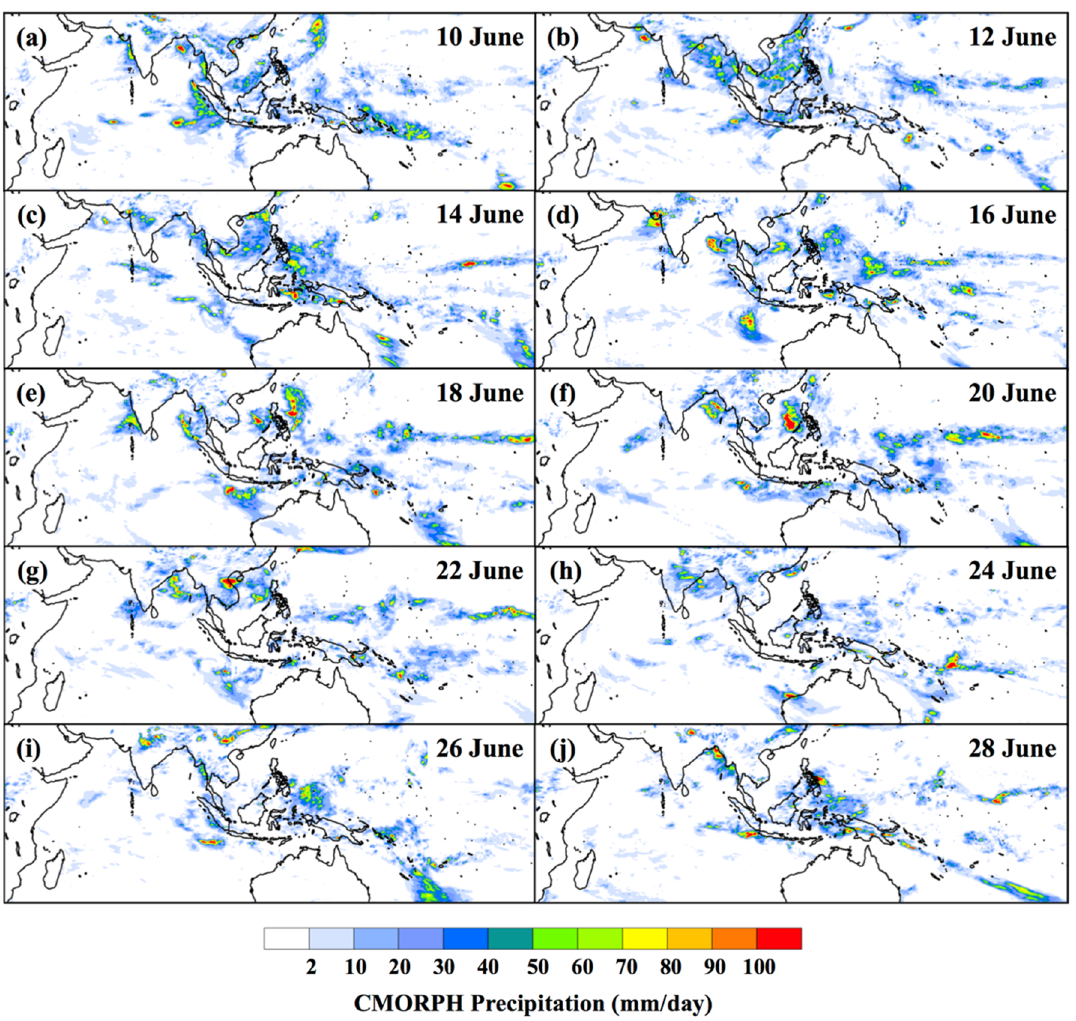
Figure 4. CMORPH daily precipitation over the region 30° S to 30° N and 30° E to 150° W. for the period 10–28 June 2013 ( a – j